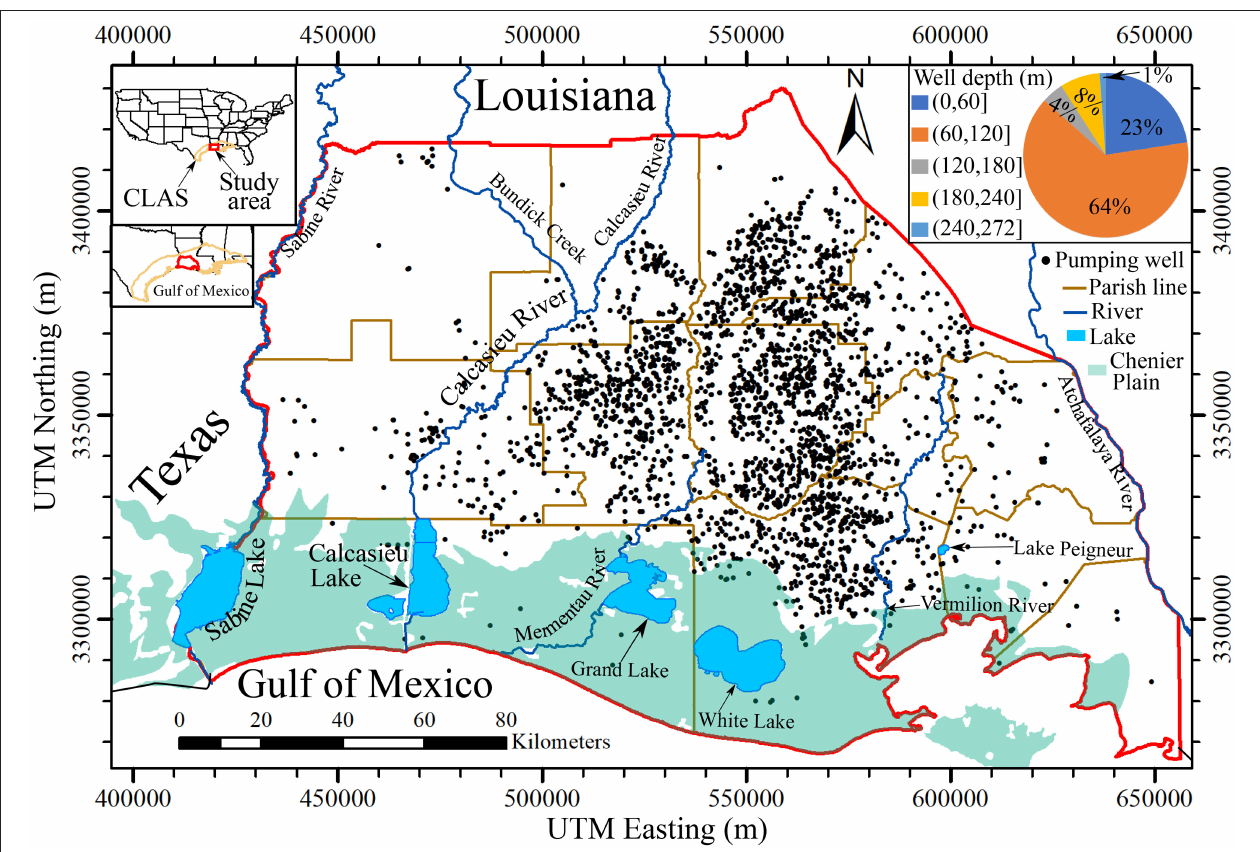
FIGURE 1 | Chicot aquifer domain (red line). Black dots are pumping wells. Blue lines show the major rivers in the Chicot aquifer domain. The pie chart shows the fractions for depth ranges of pumping wells. The coordinates are in NAD83 / UTM zone